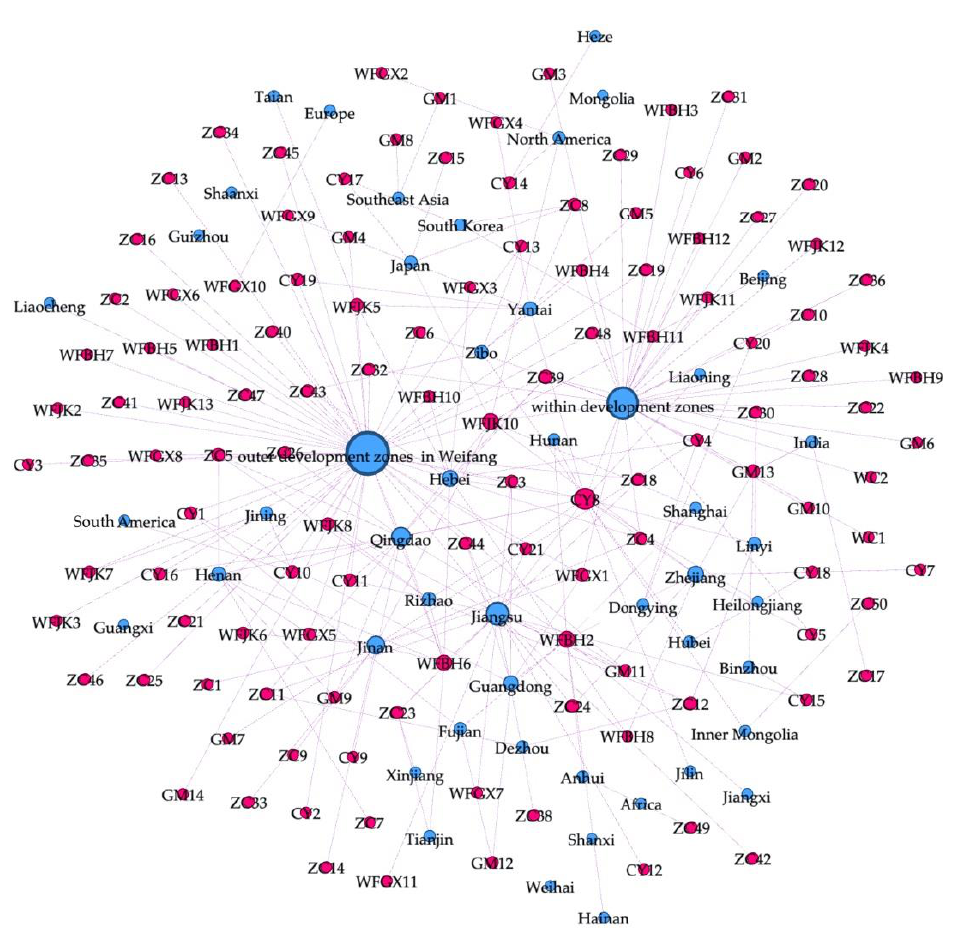
Figure 4. Firms’ supply logistics networks in Weifang’s development zones before the outbreak of the pandemic. Note: The blue and red dots represent the supply originations and the enterprises in the development zones, respectively; the lines represent the connection between the supply originations and the enterprises in the development zones. A larger dot indicates that the node has a higher degree centrality in the networks.